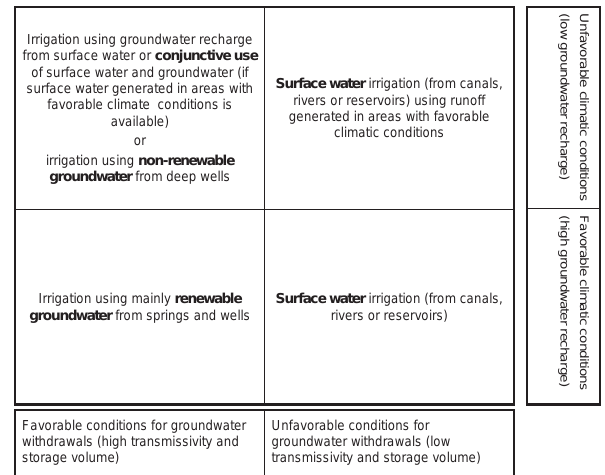
Fig. 5. General typology of groundwater and surface water resources use in irrigation dependent on climate and aquifer